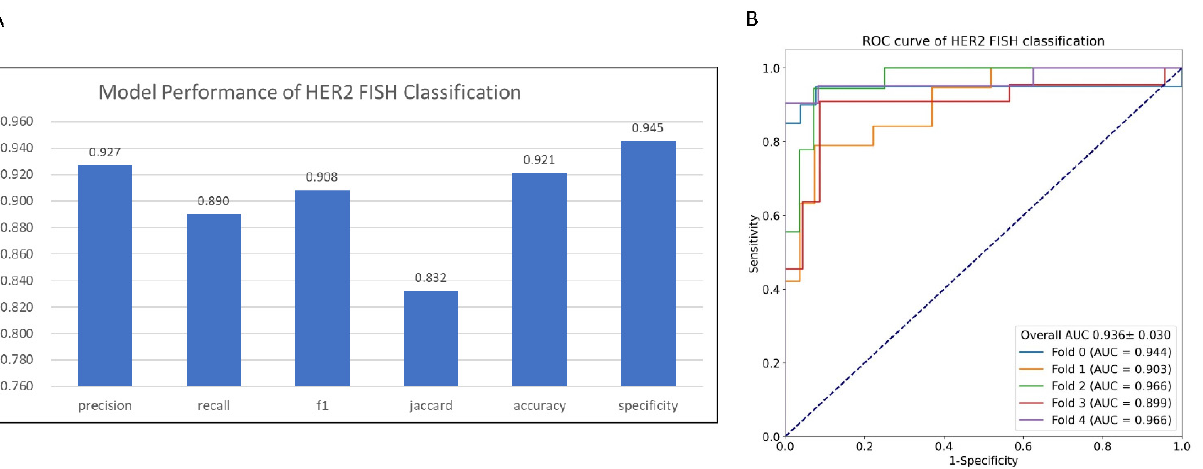
Figure 5. Performance of AI system on HER2 FISH classification. ( A ) Histograms of GrayMap model performance. ( B ) ROC curve of HER2 FISH status classification by cross-validation classification.